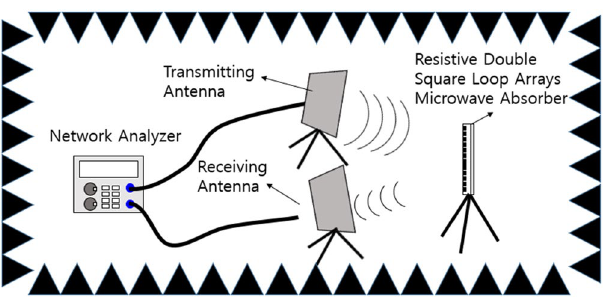
Figure 14. Schematic layout of the RCS reduction measurement system.